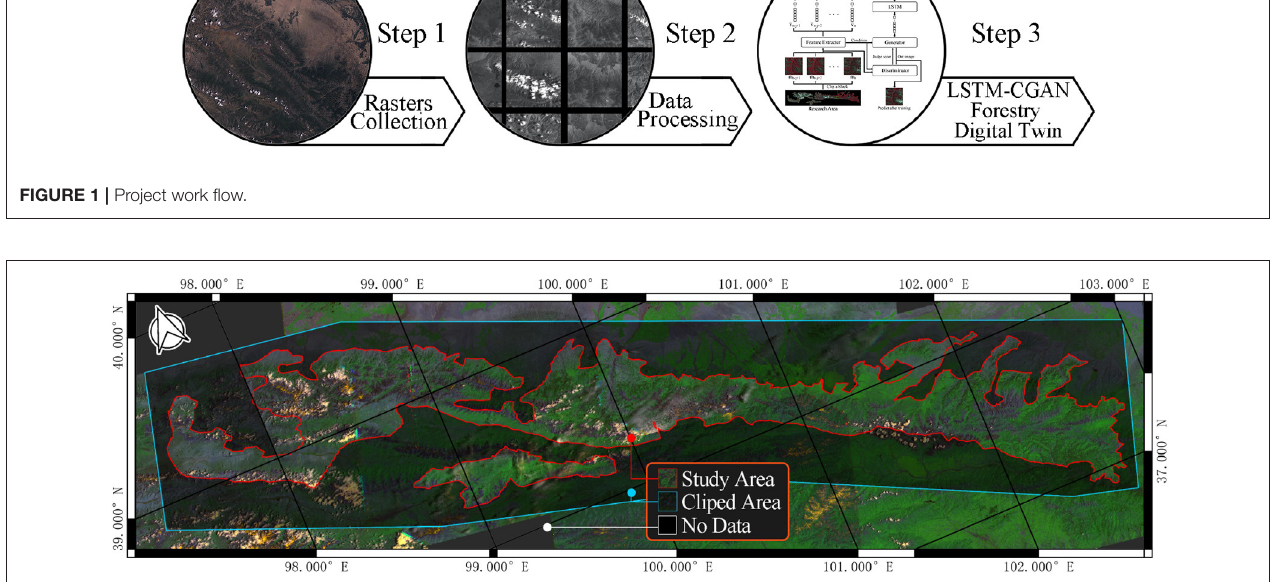
FIGURE 2 | The study